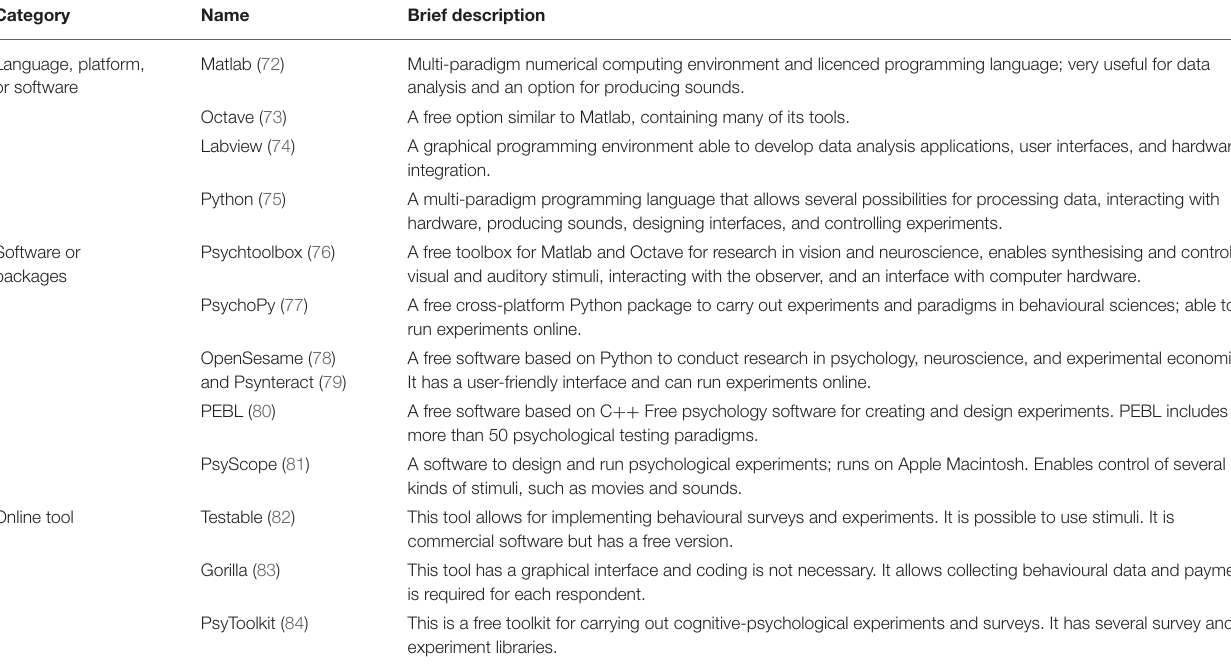
TABLE 2 | Software to analyse data and implement experiments in the behavioural sciences.